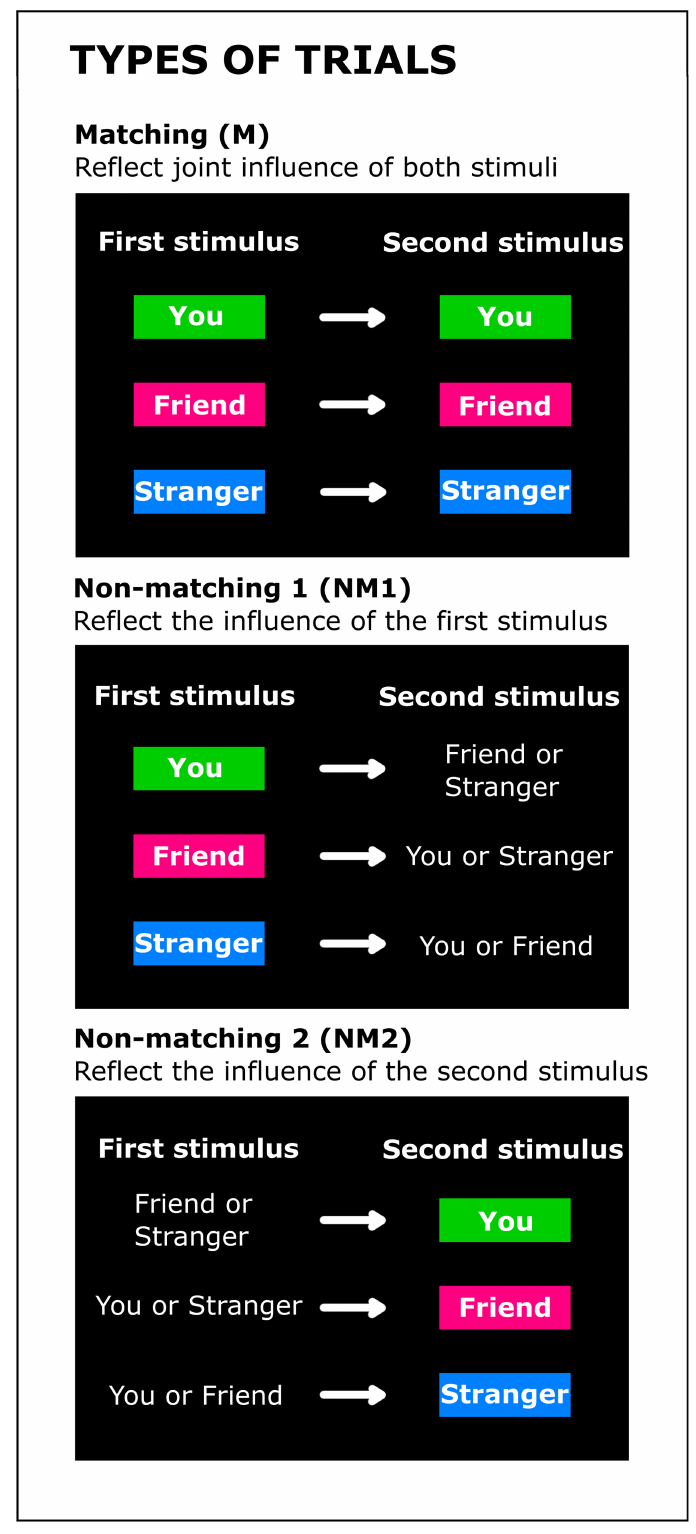
PLOS ONE | https://doi.org/10.1371/journal.pone.0190679 January 2,